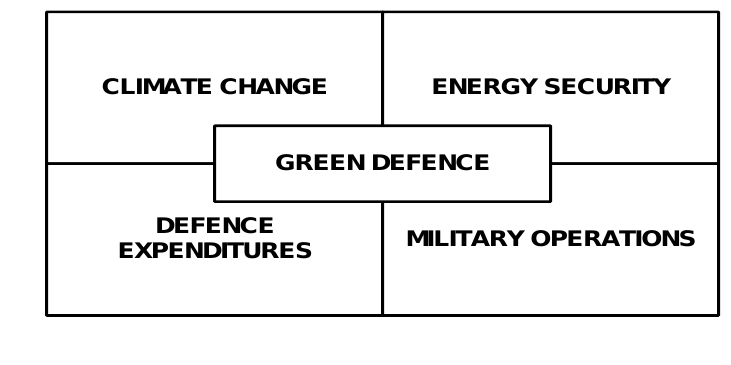
Figure 1 – Green defence concept and security challenges Рис. 1 – Концепция «зеленой обороны» и проблемы безопасности Слика 1 – Концепт зелене одбране и безбедносни